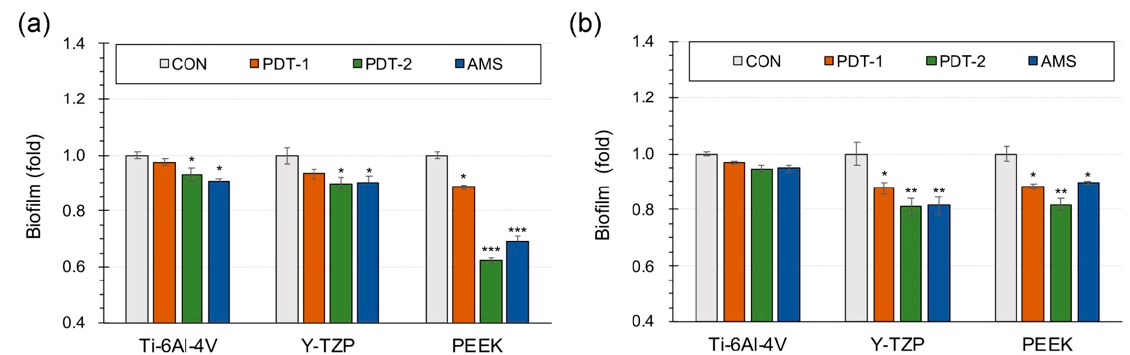
Figure 6. The biofilm removal efficacy of different therapeutic approaches in pre-existing oral microbe biofilms: ( a ) S. mutans and ( b ) A. actinomycetemcomitans . CON, PDT-1, and PDT-2 correspond to the group using different temoporfin concentrations of 0, 1.0, and 2.0 μ g/mL, respectively; AMS is the group using 100 μ g/mL ampicillin (significant different to CON group, * p < 0.05, ** p < 0.01, *** p < 0.001).